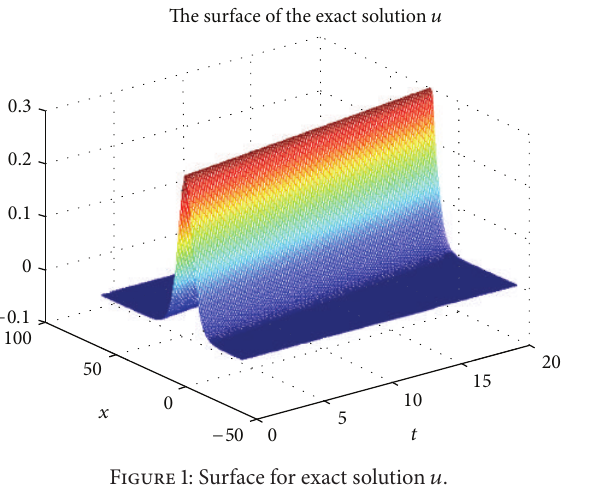
Figure 1: Surface for exact solution 𝑢 .